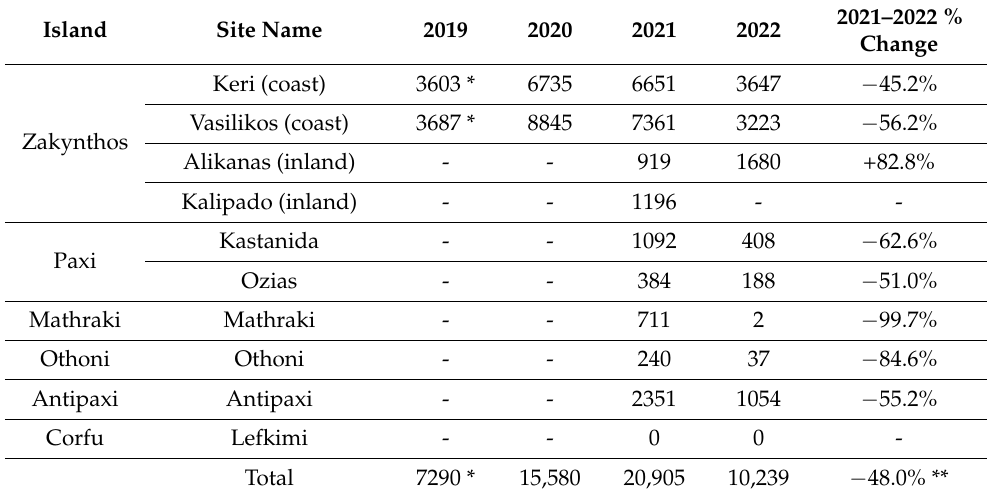
Table 1. Number of verified gunshots per spring migration and site, and percentage change of poaching activity from 2021 to